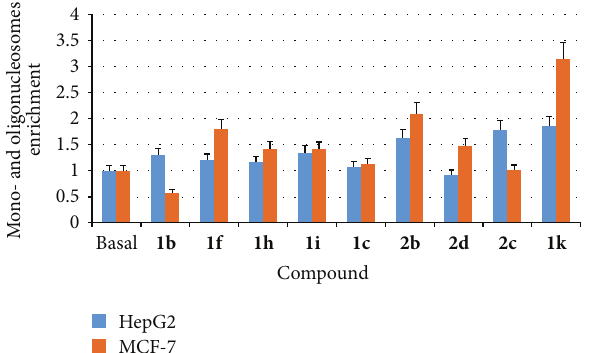
Figure 2: ELISA detection of mono- and oligonucleosomes enrich- ment after